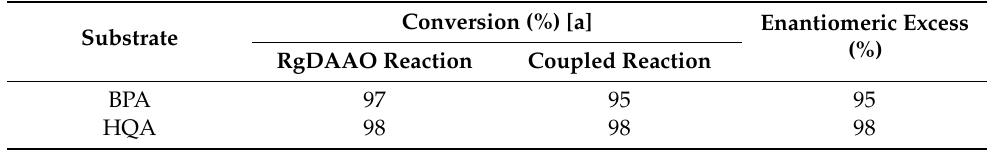
Table 2. Conversion and enantiomeric excesses of the enzymatic